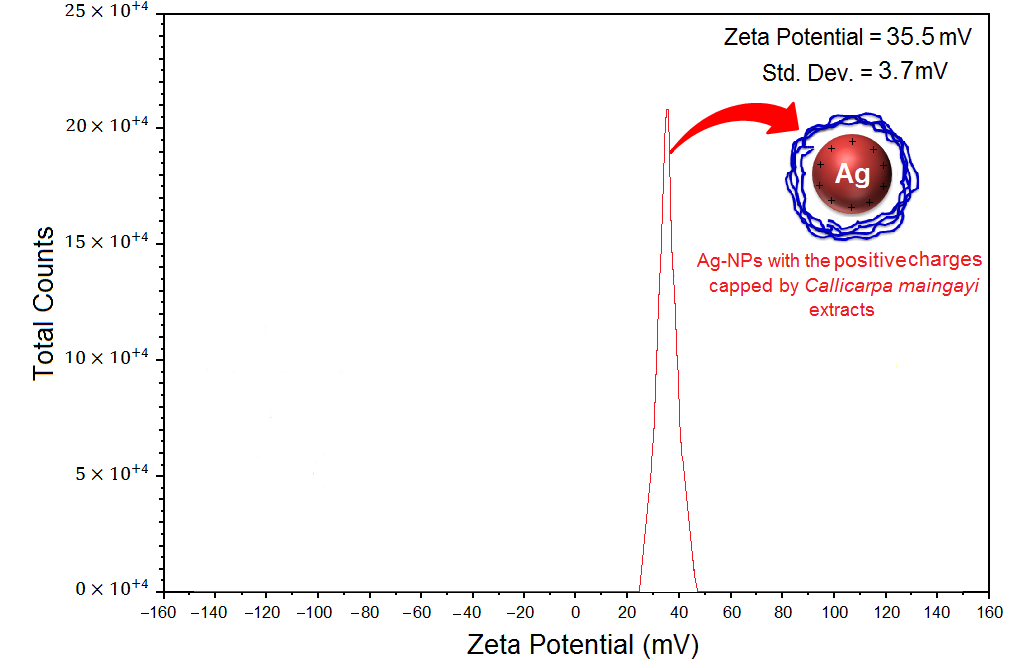
Figure 7. Zeta potential measurements for Ag/ Callicarpa maingayi extract after 48 h of stirring